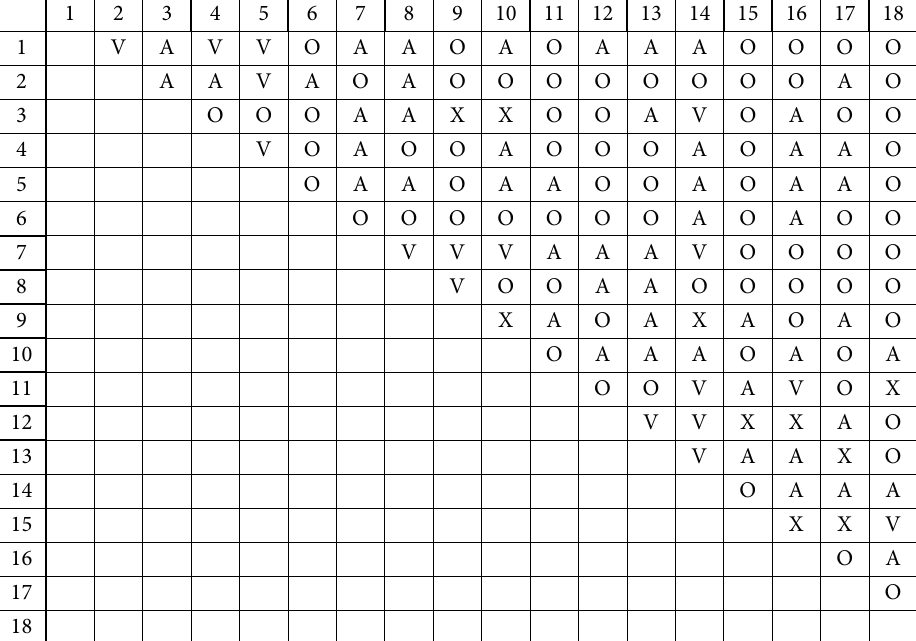
Table 3. A structural self-interaction matrix to achieve internal relationships of